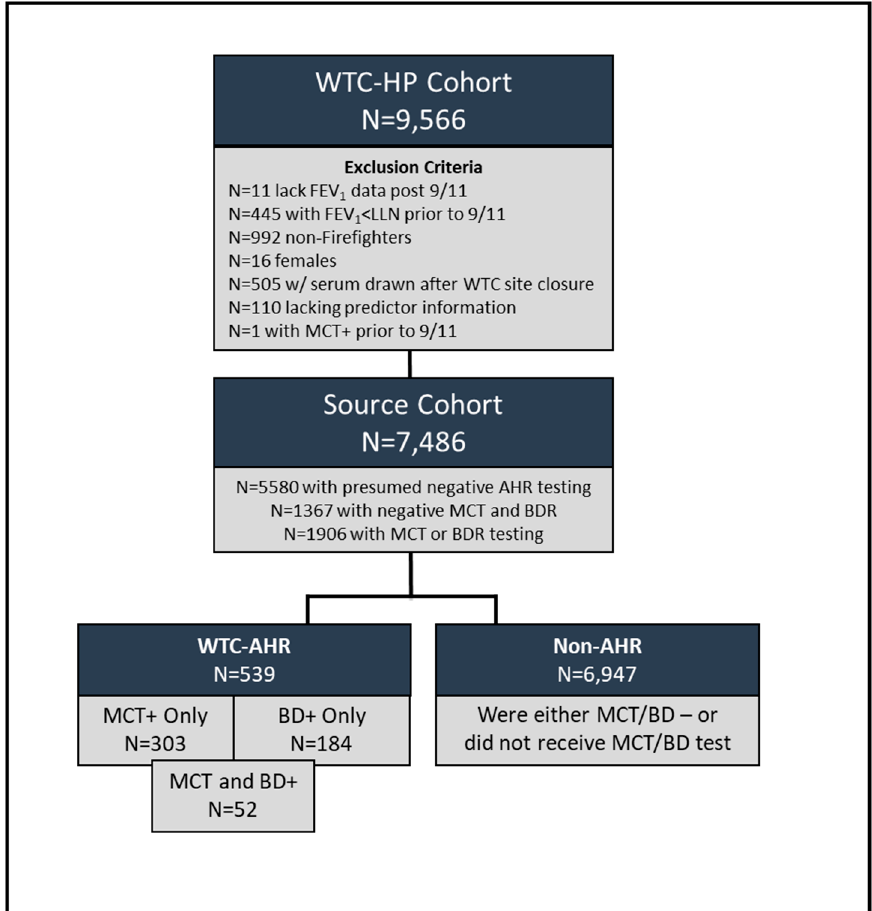
Figure 1. Study Design. Fire Department of New York (FDNY) rescue workers exposed to World Trade Center (WTC) particulates and enrolled in the WTC Health Program.